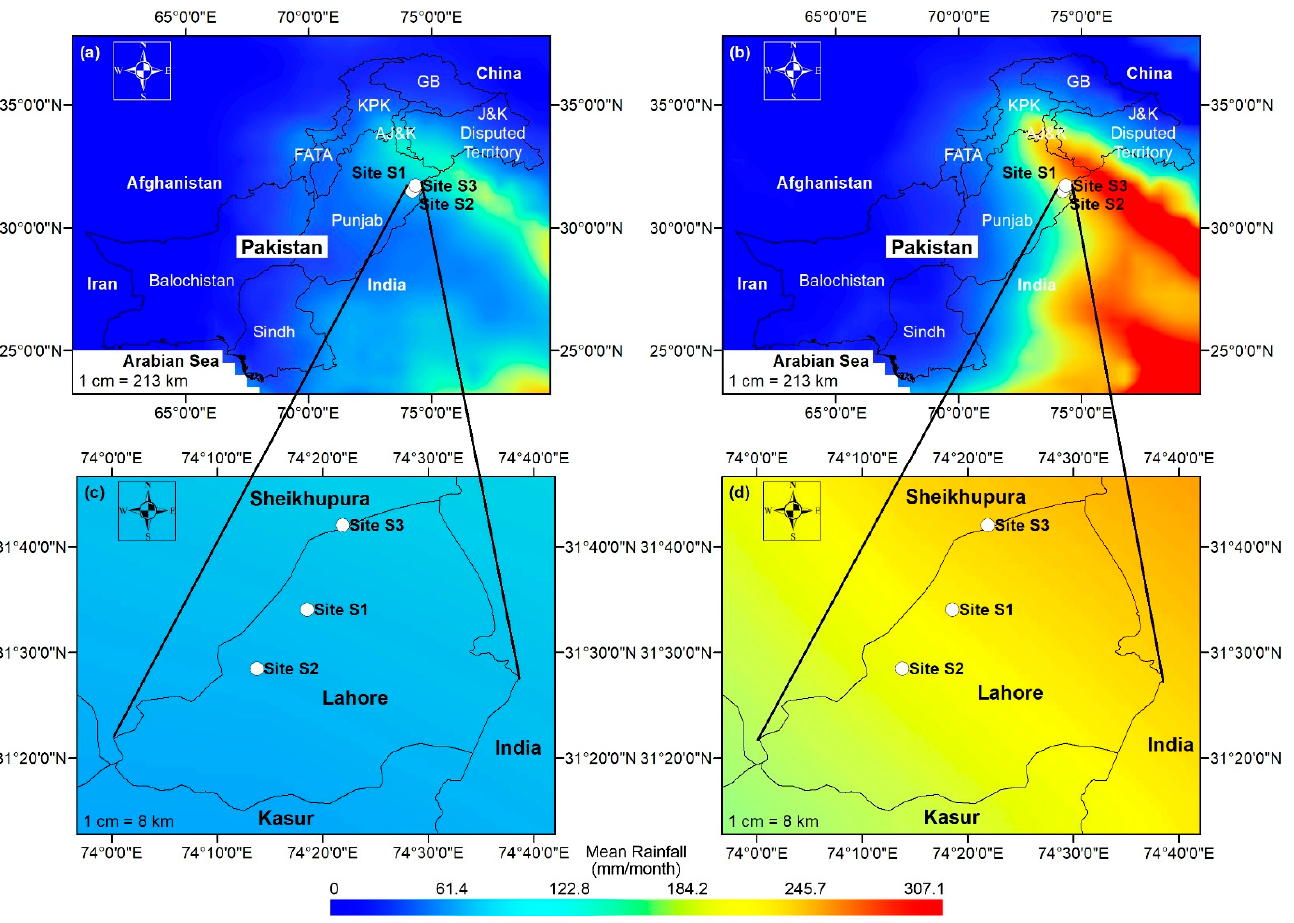
Figure 2. Profile of mean rainfall at the study sites where ( a , c ) represent June 2018, and ( b , d ) represent July 2018.